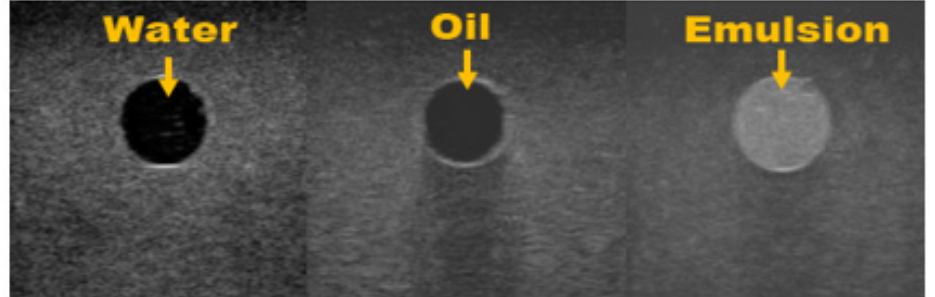
Figure 7. Comparison of echo characteristics by injected water, oil, and emulsion. The water and oil appear echo-free, but the emulsions are hyperechoic. Unlike pure water or oil, emulsions have varying acoustic impedance. Water and oil contained in the emulsion solutions are mixtures, and they appear increasingly hyperechoic as the internal interface increases.